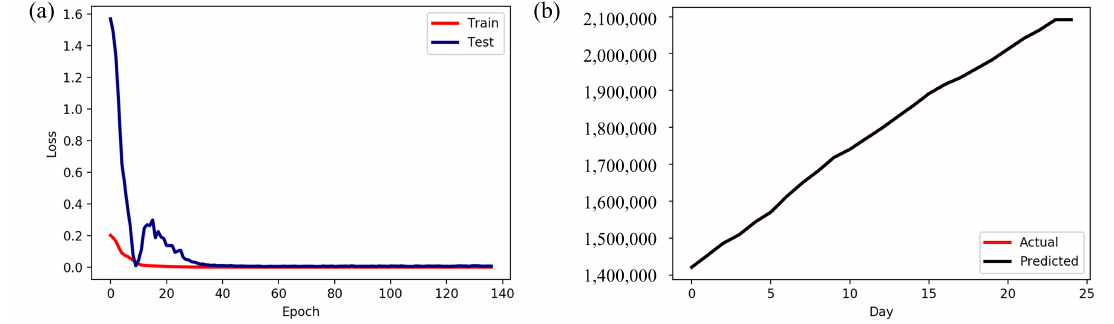
Figure 8. Case study of the network training for USA. ( a ) training loss during training, and ( b ) active case prediction on validation data.